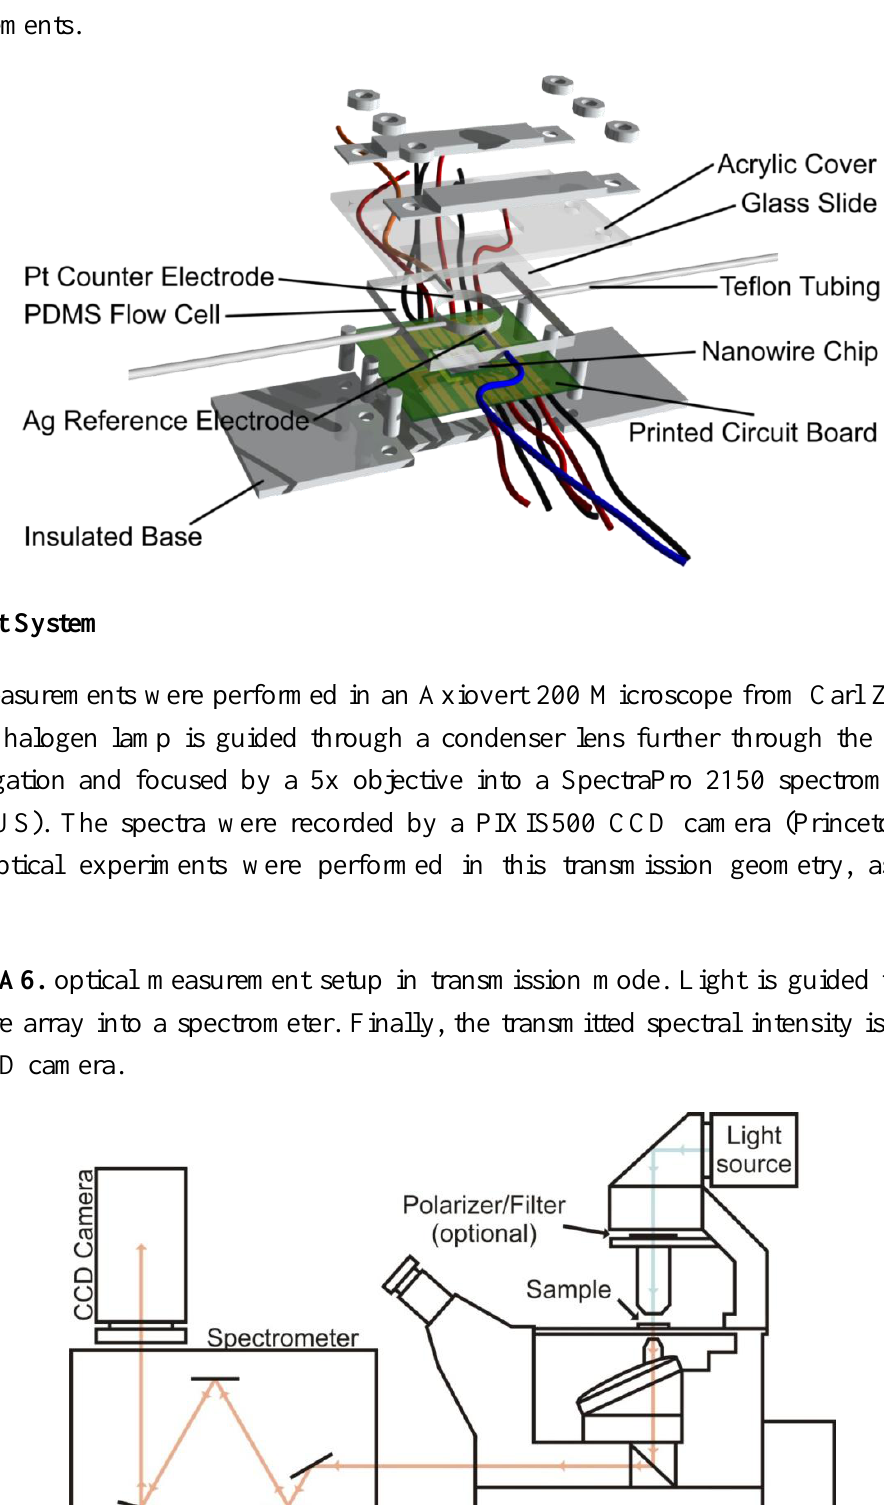
Figure A5. A custom built electrochemical flow cell in its disassembled state. The flow cell itself consists of PDMS which is pressed against the PCB and sealed on the upper side by a glass slide. The flow chamber has a cylindrical shape (height: 2 mm, diameter: 11 mm) with a total volume of roughly 200 µl. Two 0.8 mm Teflon tubes were inserted into two adjacent flow channels of the cell while a silver reference and a platinum counter